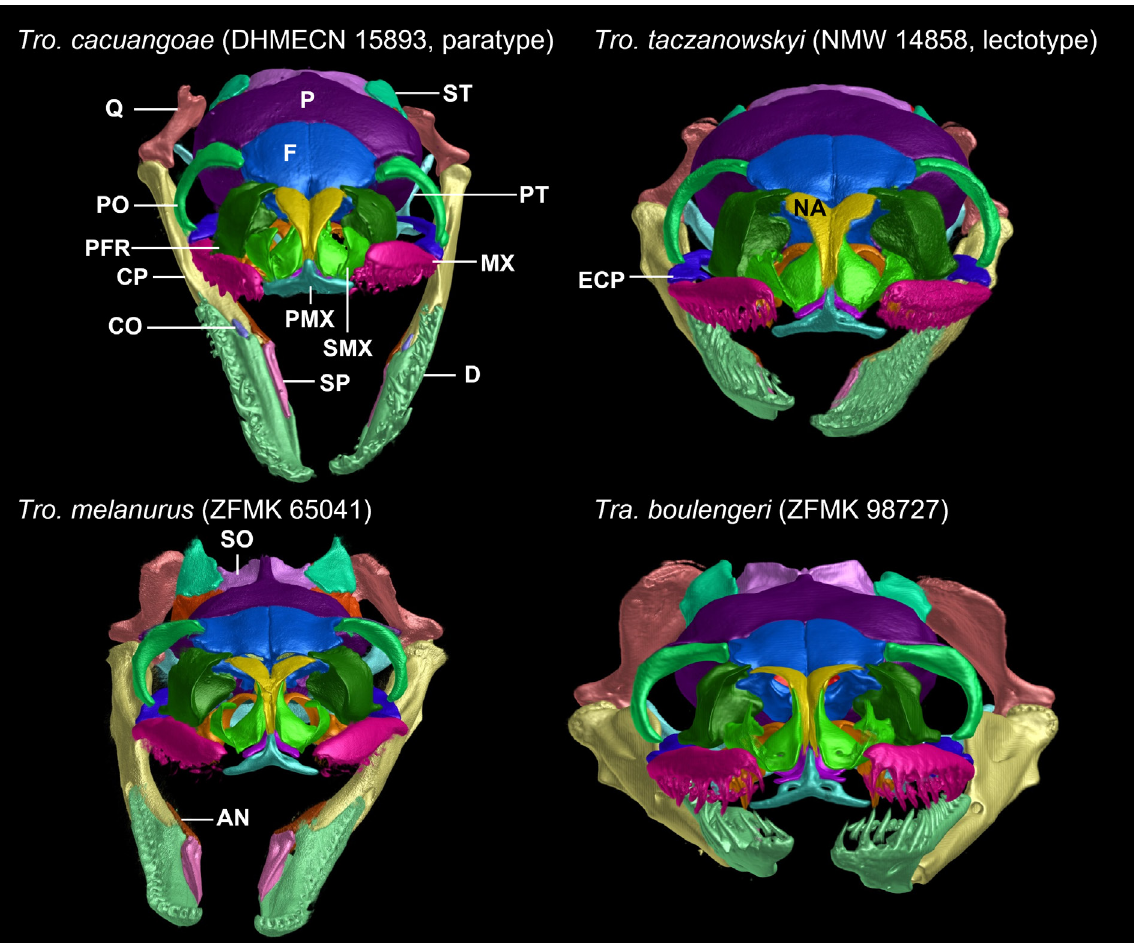
Fig. 10. Micro-CT images of the anterior view of the skulls of Tropidophis cacuangoae sp. nov., ♀ (DHMECN 15893, paratype), T. taczanowskyi (Steindachner, 1880) (NMW 14858, lectotype), T. melanurus (Schlegel, 1837) (ZFMK 65041), and Trachyboa boulengeri Peracca, 1910 (ZFMK 98727). Different skull elements are digitally colored for better visualization. Abbreviations: AN = angular; CO = coronoid; CP = compound bone; D = dentary; ECP = ectopterygoid; F = frontal; MX = maxilla; NA = nasal; P = parietal; PFR = prefrontal; PMX = premaxilla; PO = postorbital; PT = pterygoid; Q = quadrate; SMX = septomaxilla; SO = supraoccipital; SP = splenial; ST =